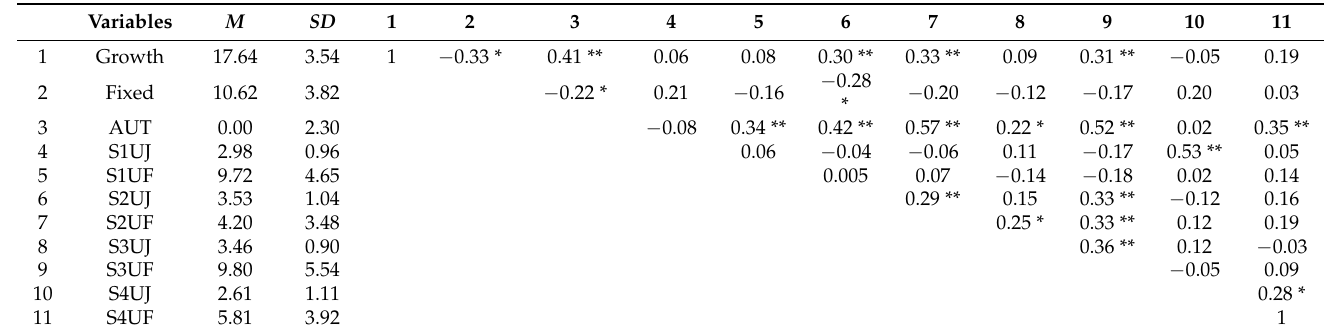
Table 1. Means (M), standard deviations (SD), and correlations among